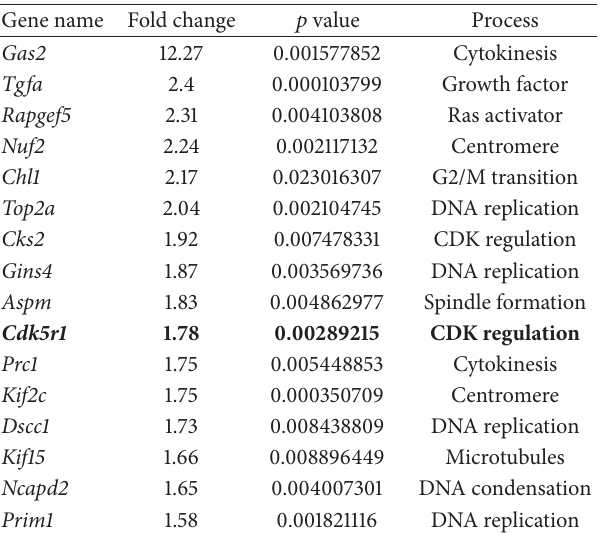
Table 1: Cell cycle associated genes upregulated by Nr4a1 and Nr4a3 but not Nkx6.1. Genes upregulated by Nr4a1 and Nr4a3 that are not regulated by Nkx6.1 were selected based on changes greater than 1.5-fold and 𝑝 values less than 0.05. Genes were defined by the GO category cell